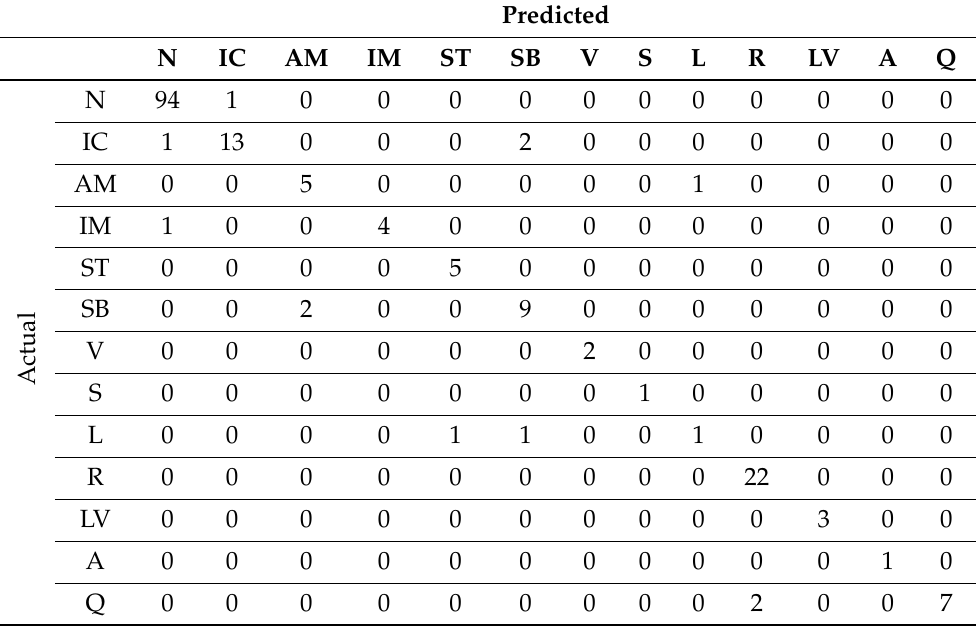
Table 11. Confusion Matrix of the Classified Arrhythmia